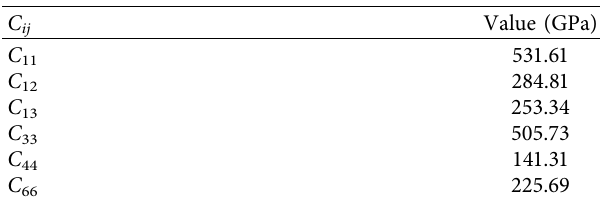
Figure 1: The crystal structure of EuFe 2 As 2. The structure was viewed using Xcrysden, a package in QUANTUM ESPRESSO. The structure is made up of three atoms, namely, europium, iron, and arsenic. It is similar to the structure in past studies on the com- pound as seen in [23]. Table 2: Elastic